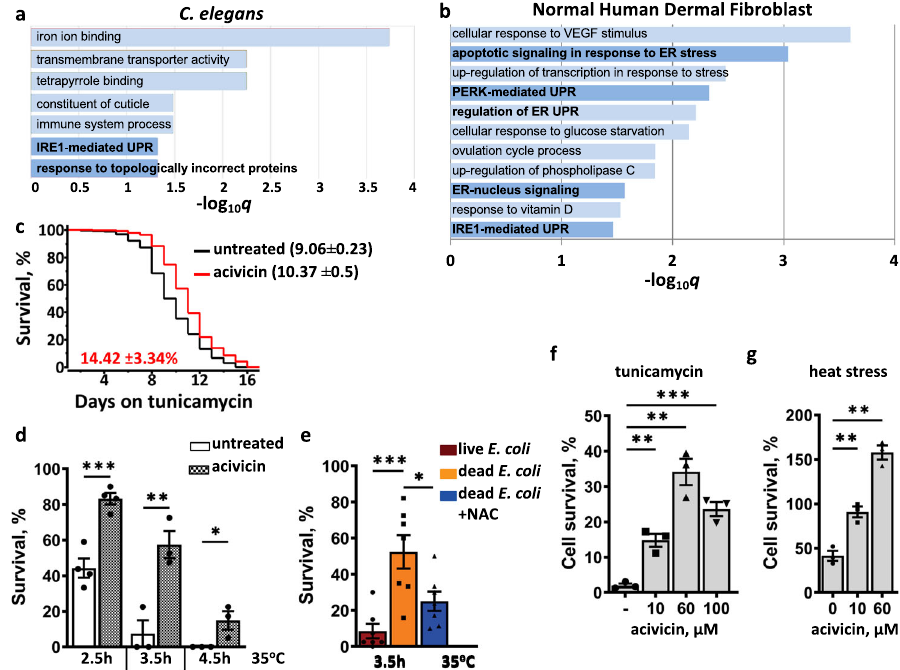
Fig. 7 Evolutionary conservation of the response to dietary thiols restriction. UPR is the highly enriched (gene ontology) category among the genes upregulated by acivicin in C. elegans (>0.5 log 2 fold) ( a ) and in human dermal fi broblasts (>1 log 2 fold) ( b ); see also Supplementary Data 2 and 3. Worms pretreated with acivicin are resistant to tunicamycin ( c ) and heat ( d ). WT worms were exposed to 75 µ M acivicin from eggs until day 2 of adulthood and then subjected to proteotoxic stress (see Experimental procedures). The graph represents the composite of three independent experiments. In c , the average percentage survival change ±SD relative to untreated control is indicated in red ( n = 150). In d , the graph represents an average ±SEM from at least three independent experiments ( n = 109 – 150 worms). e Worms reared on dead E. coli diet are resistant to heat stress. WT worms reared on live, dead or dead + NAC E. coli diet until day 2 of adulthood and then subjected to heat stress (35 °C, 3.5 h). The graph represents an average ±SEM from seven independent experiments ( n = 201 – 278 worms). See also Supplementary Table 11. Normal human dermal fi broblasts pretreated with acivicin are resistant to tunicamycin ( f ) and heat ( g ). Cells were pretreated with indicated concentration of acivicin for 24 h and then exposed to 10 μ g ml − 1 tunicamycin for 48 h ( f ) or heat shocked at 46 °C for 3 h ( g ). Survival was assessed 24 h later. Three independent experiments were performed and percent survival ±SEM was calculated against unstressed control supplemented with the same concentration of acivicin. See also Supplementary Fig. 11c, d. In all graphs p values